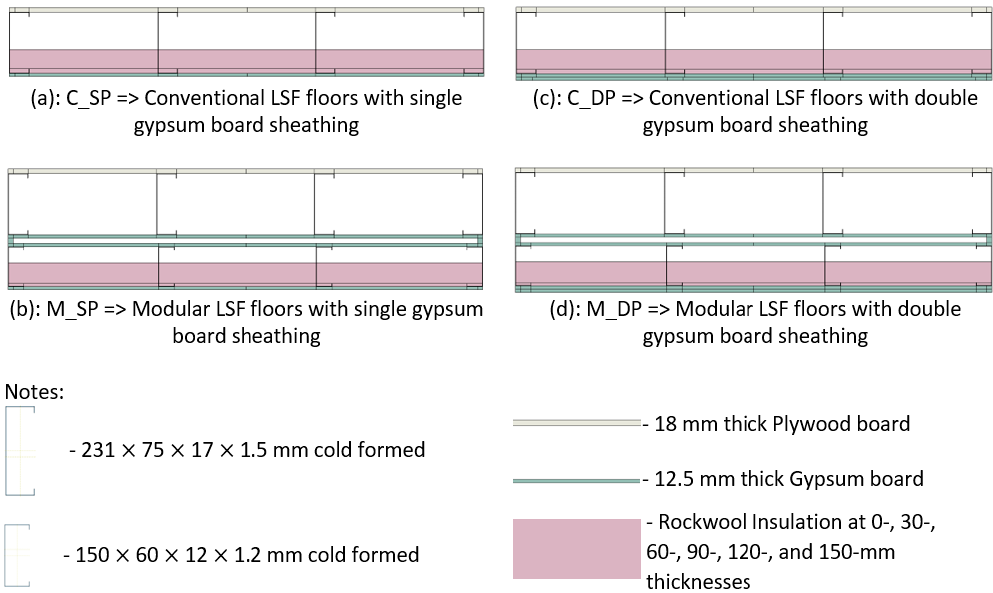
Figure 7. Parametric floor systema; ( a ): C_SP; ( b ): M_SP; ( c ): C_DP & ( d ) M_DP.